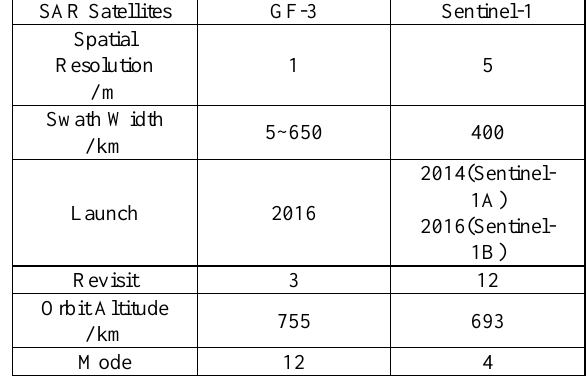
Table 3. Parameters of GF-3 and